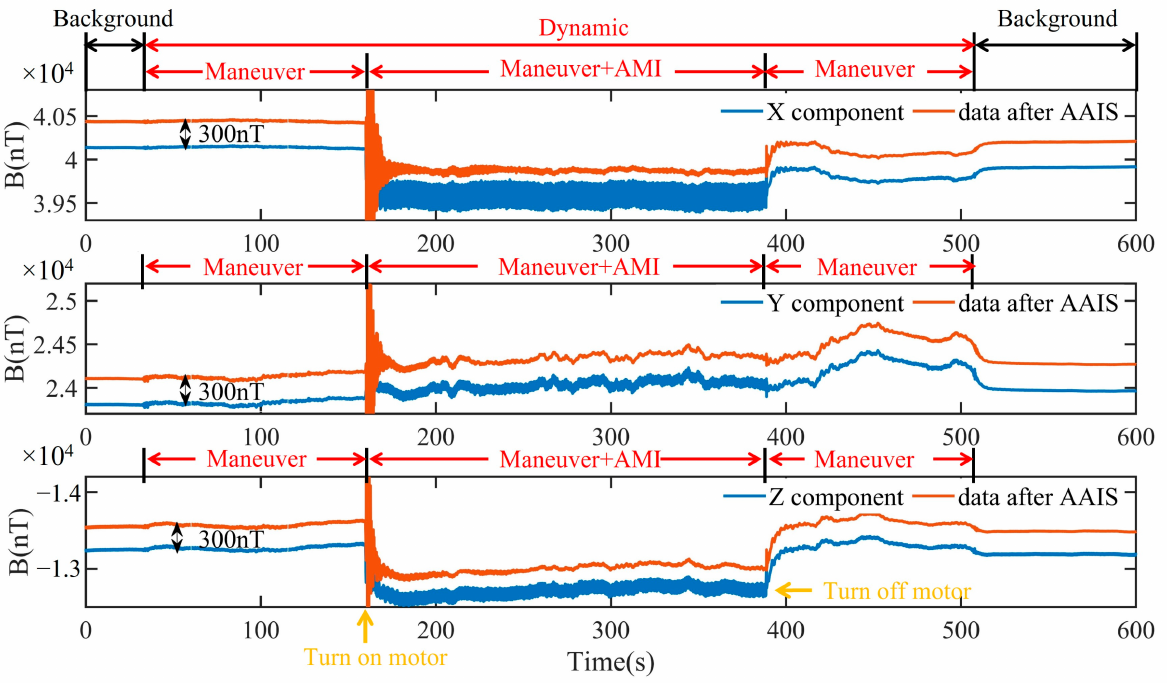
Figure 10. In the dynamic experiment, the components of the magnetic field before and after AAIS. The frequency spectrum of the data measured by the magnetometer and processed by the AAIS algorithm when the maneuver and AMI coexist (160 s to 390 s) is shown in Figure 11. This result indicates that AAIS detected four frequencies of AMI: 1.30 Hz, 2.20 Hz, 4.80 Hz, and 6.70 Hz. In Figure 11a, the total magnetic field contains four frequencies of AMI but without maneuver frequencies. The AAIS then suppresses the AMI of the four frequencies on three components, as shown in Figure 11b–d. The results demonstrate that AAIS suppressed the AMIs excellently and preserved the information of the platform maneuver